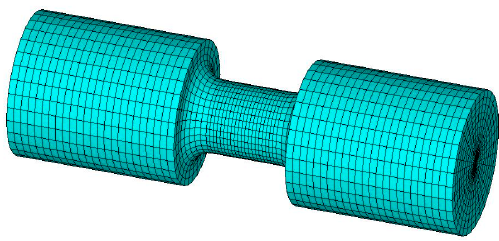
Figure 10. Finite element model of specimen.